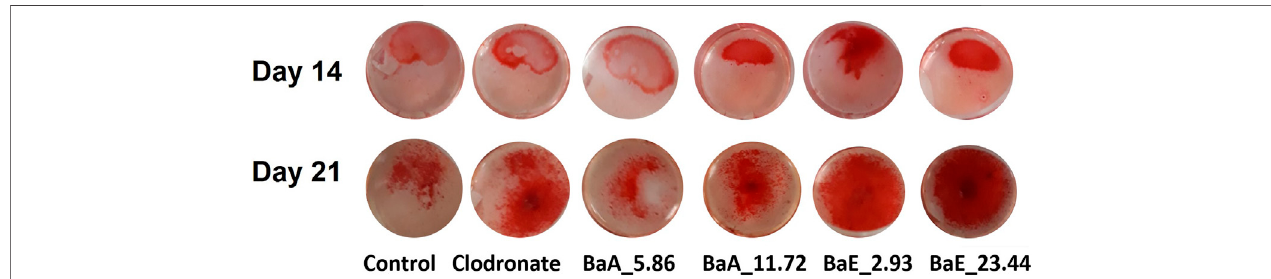
FIGURE8| PhotomicrographsofmineraldepositionsstainedwithAlizarin Redstainingin B.acmella aqueous( Ba A)and ethanol( Ba E) extractsonDay 14andDay 21. Control (untreated cells), Positive control (Clodronate), BaE_2.93 (BaE at 2.93 μ g/ml), BaE_23.44 (BaE at 23.44 μ g/ml), BaA_5.86 (BaA at 5.86 μ g/ml) and BaA_11.72 (BaA at 11.72 μ